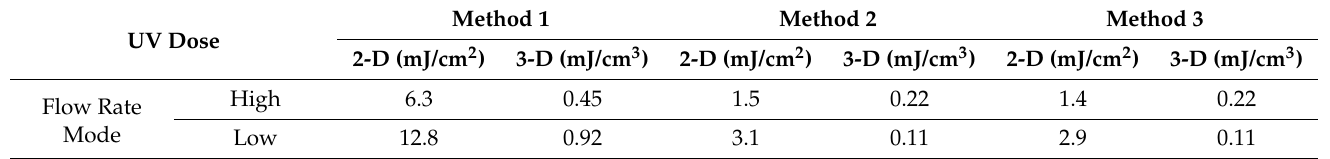
Table 5. Summary of UV dose estimations based on the three